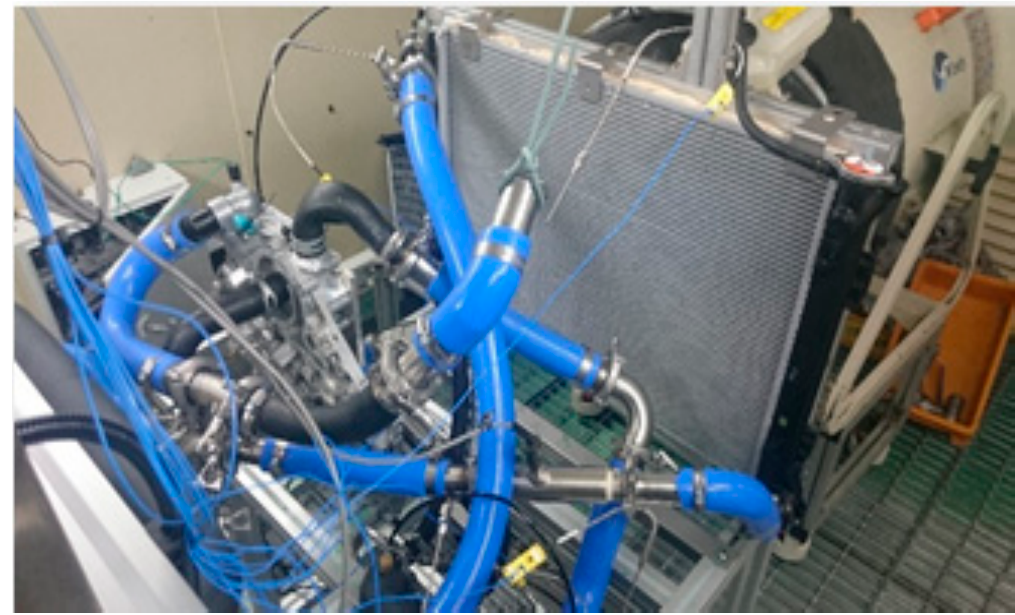
Figure 2. Measurement device that simulates the cooling system located inside the environmental chamber. It is configured to control the external temperature and amount of air blown to the front of